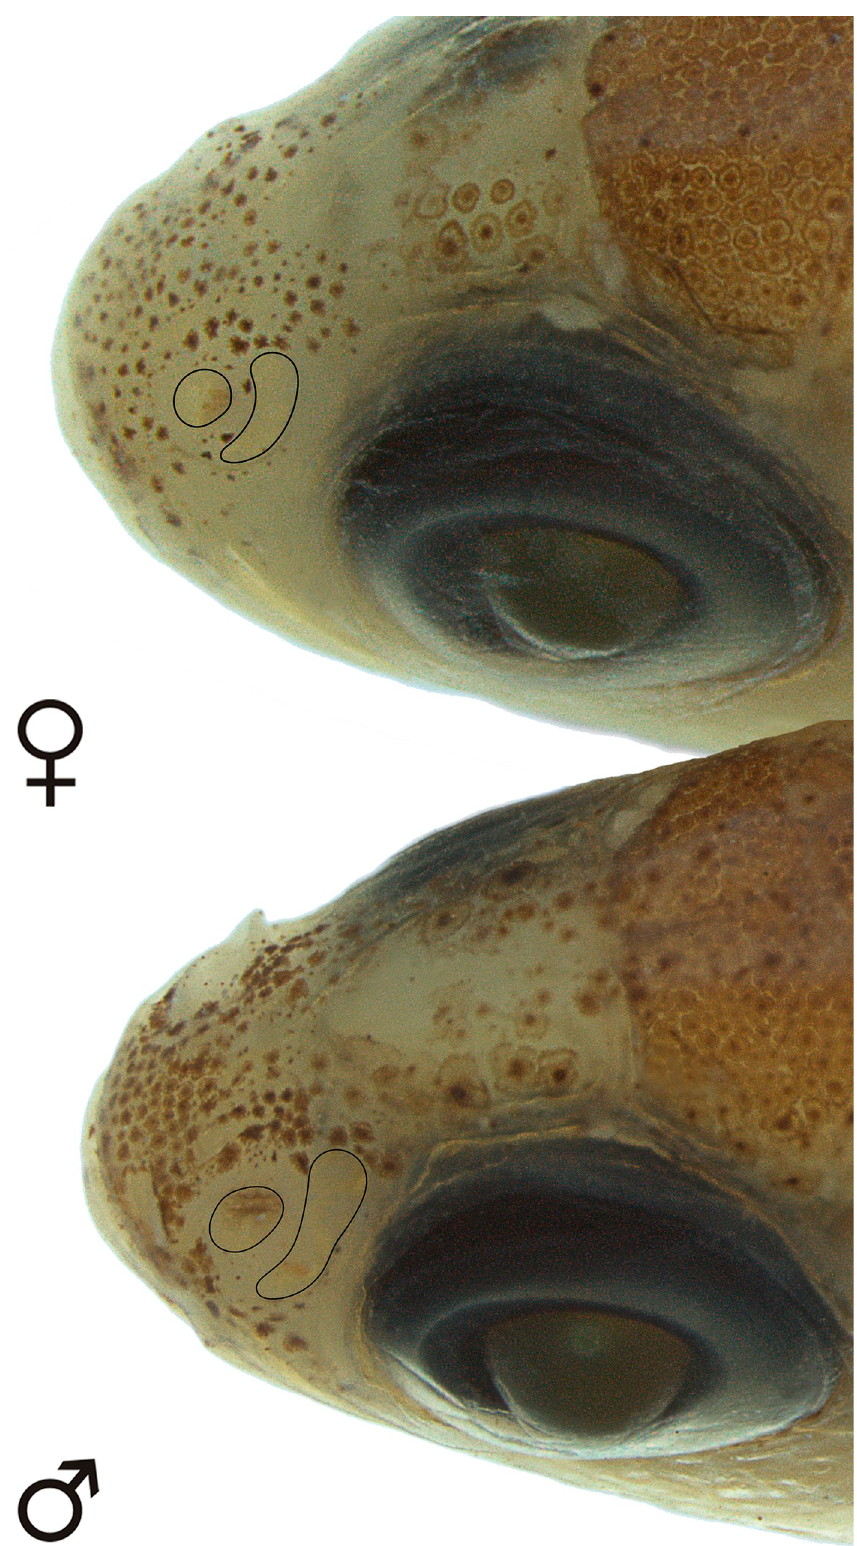
Fig 6. Dimorphic nostril openings of Tyttobrycon shibattai . MZUSP 125268, holotype, male, 17.1 mm SL. MZUSP 125269, paratype, female, 17.6 mm SL.